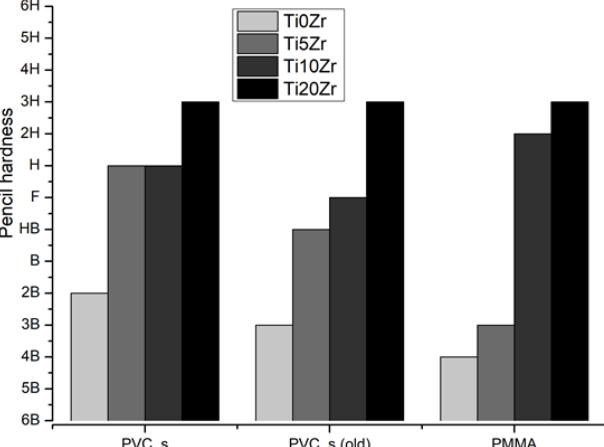
Figure 6. Mechanical stability measured by hardness pencil test.